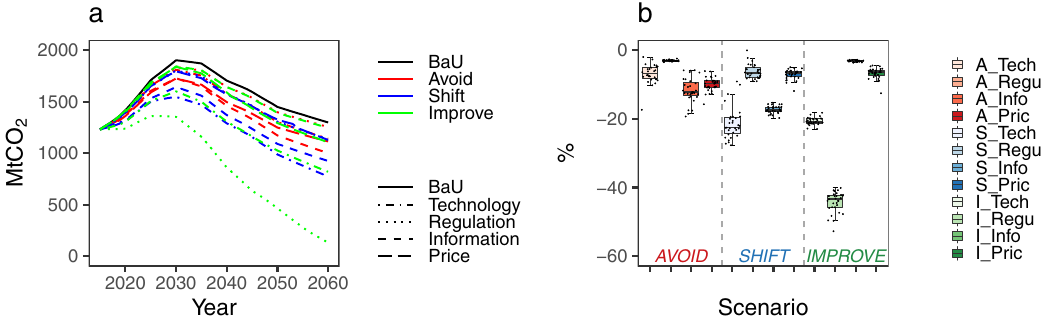
Fig. 2 CO 2 from the ground transport sector in China. a Emission trajectories in China from 2015 to 2060. b Cumulative emission reduction potentials from 2015 to 2060 in 12 scenarios compared with the BaU scenario. In the box plot, data are presented as median and minimum/maximum values in 31 provinces. The box shows fi rst and third quartile, and the whiskers are the maximum and minimum